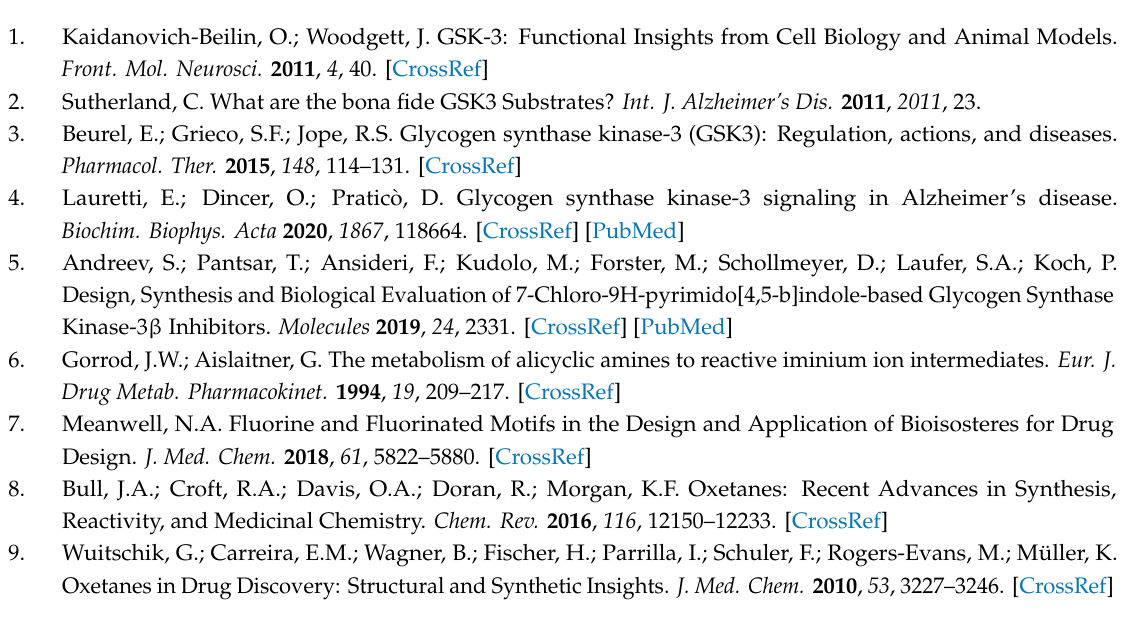
simulations; Figure S2: Evaluation of the cytotoxic potential of (R) -28 cell lines; Figure S3: Evaluation of the cytotoxic potential of (R) -28 on cancer cell lines; Figure S4: Compound (R) -28 inhibits GSK-3 β activity in neuronal SH-SY5Y cells; Figure S5: Neuroprotective e ff ects of (R) -28 against the neurotoxicity induced by H 2 O 2 and OA β 1–42 in neuronal SH-SY5Y cells; Table S1: Chromatographic gradient for separation of metabolism analytes. Scheme S1: Synthetic route to 4-chloro-9 H -pyrimido[4,5- b ]indoles 3a – l . The QM output conformations and